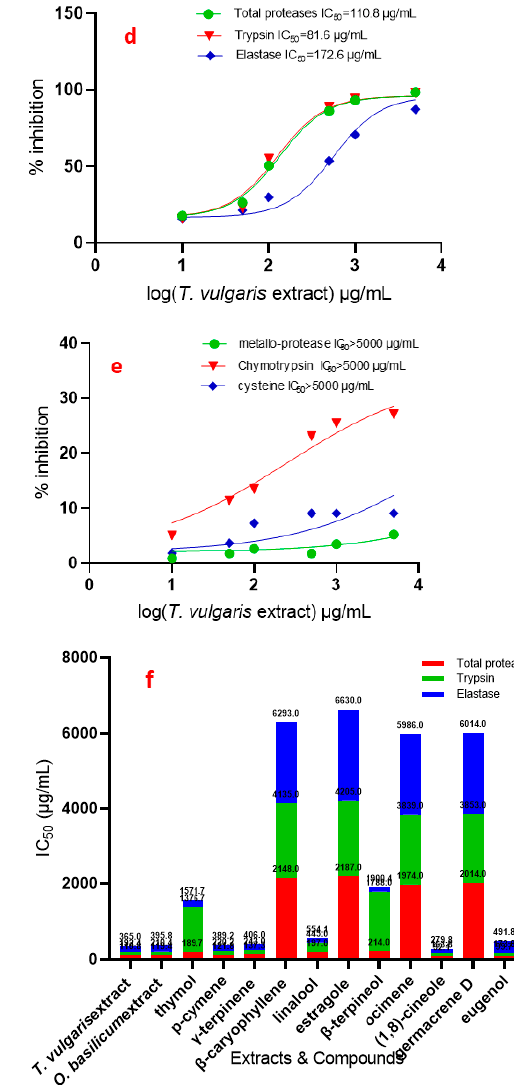
Figure 4. IC 50 (in vitro) of T. vulgaris and O. basilicum extract from cell suspensions and compounds against total proteases, trypsin, chymotrypsin, elastase, cysteine, and metallo-protease of R. ferrugineus midgut. ( a ) IC 50 of O. basilicum against total proteases, trypsin, elastase and ( b ) IC 50 of O. basilicum against metallo-protease, chymotrypsin and cysteine, ( c , f ) IC 50 of T. vulgaris and O. basilicum extract, thymol, p -cymene, γ -terpinene, linalool, β -terpineol, 1,8-cineole and eugenol against total proteases, trypsin, elastase, ( d ) IC 50 of T. vulgaris against total proteases, trypsin, elastase, ( e ) IC 50 of T. vulgaris against metallo-protease, chymotrypsin and